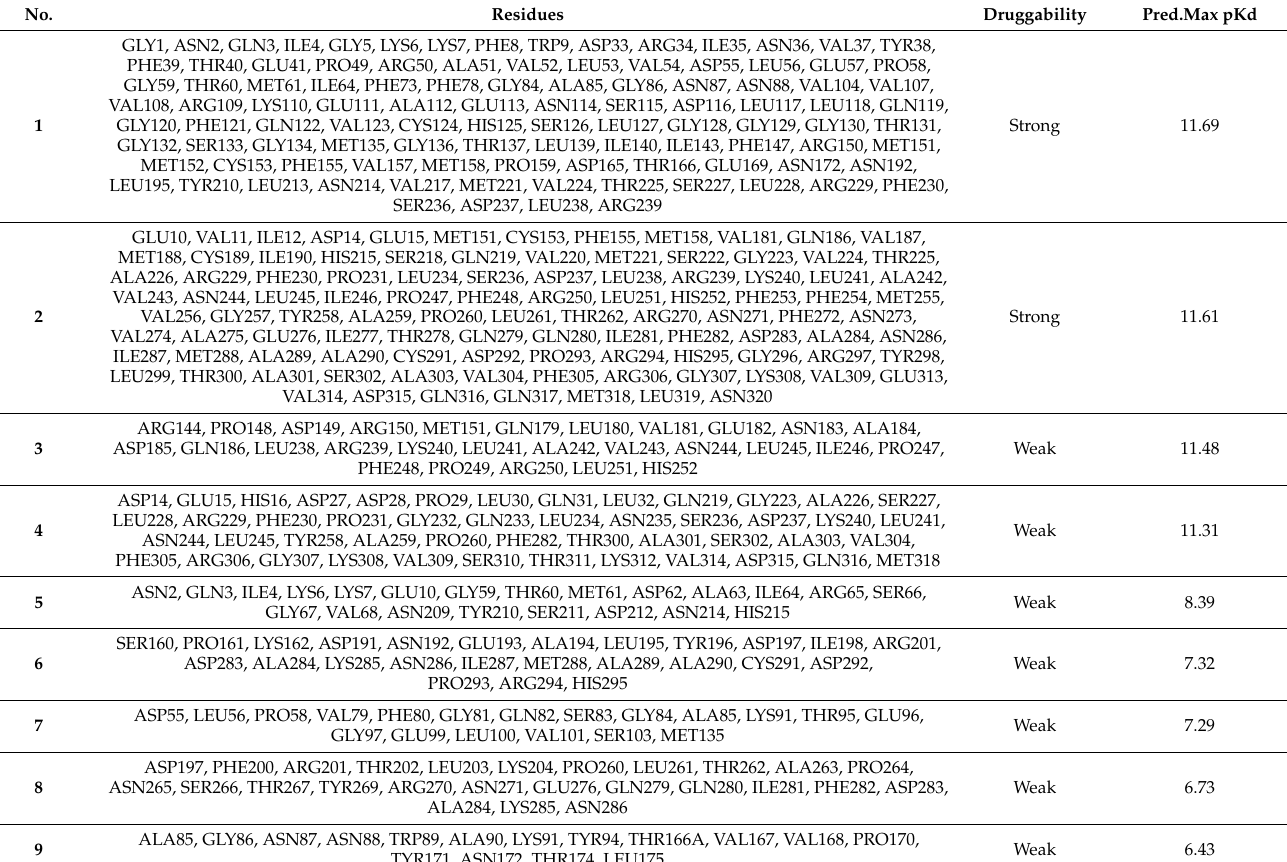
Figure 1. The ramachandran figure illustrates the phi-psi torsion angles for each beta-tubulin residue. The red regions represent the most desirable phi-psi value combinations. The white region represents an undesirable phi-psi combination. Table 1. Amino sequences of beta-tubulin in each pocket